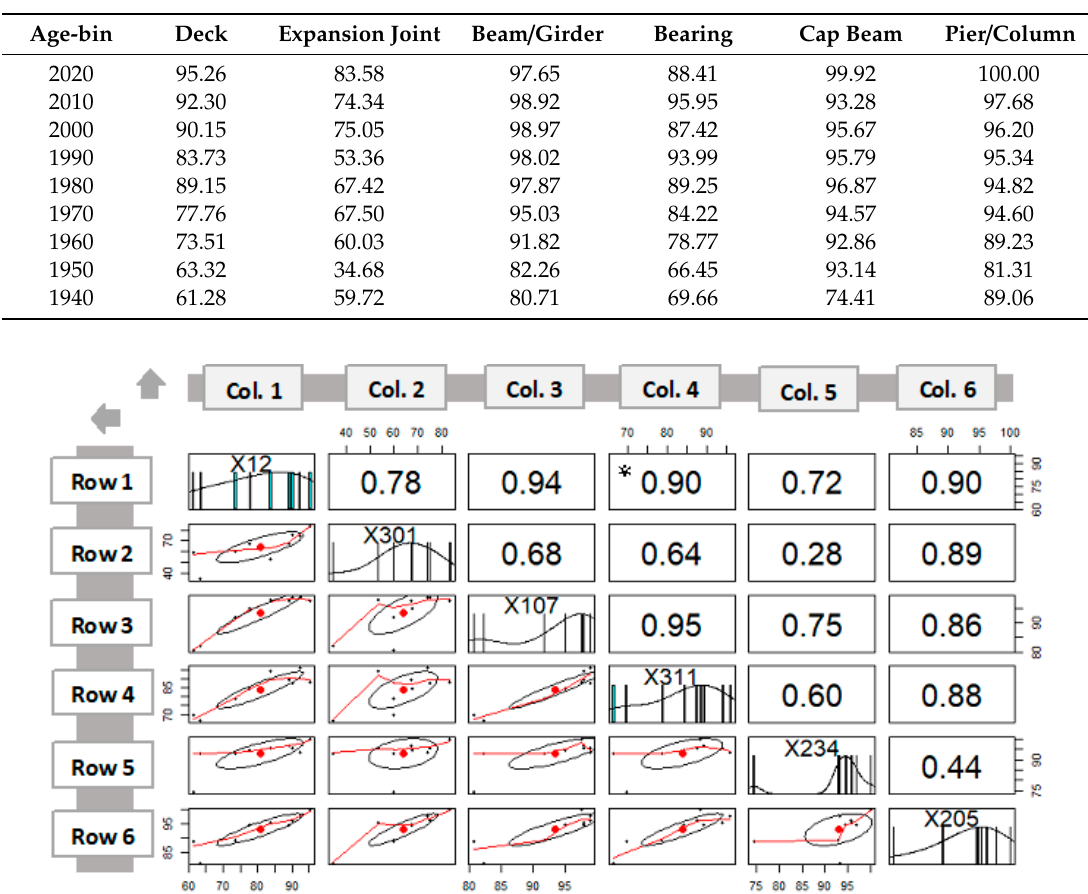
Figure 7. Contingency table for the Co-Active elements in the ‘PC109’ group.